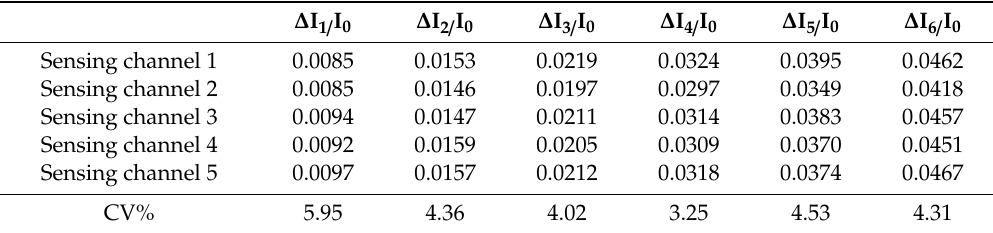
Table 3. The reproducibility of detecting streptavidin / biotin binding by the multi-microchannel FOPPR sensor system.